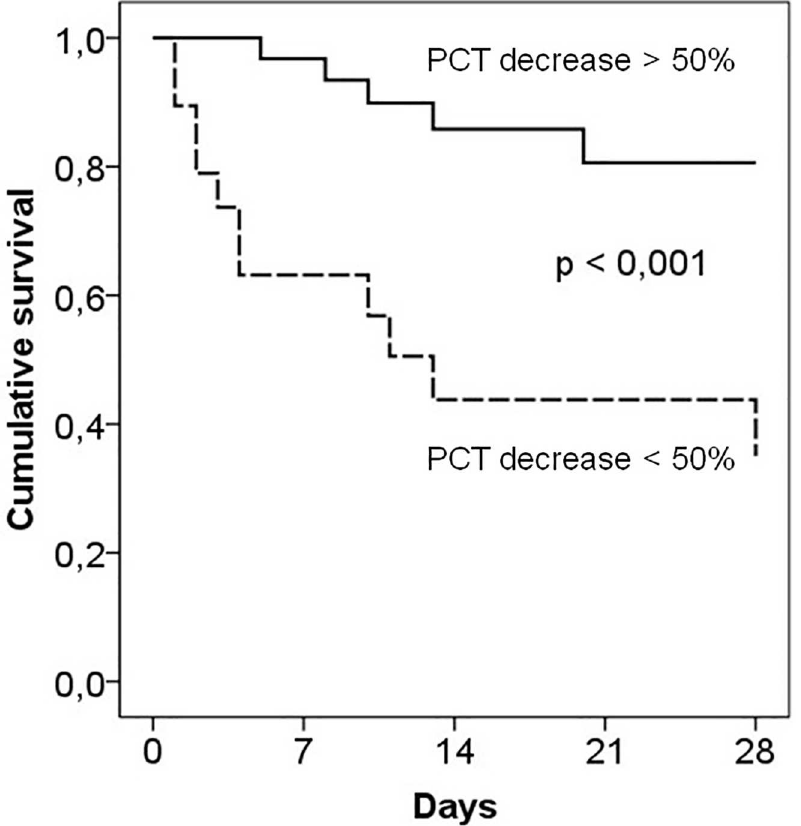
Fig 4. Kaplan Meier curves of survival of patients with severesepsis/septic shock classified in function of a decreaseof procalcitonin levels higher (continuous line) or lower (dashed line) than 50% from day 0 to 5 of ICU stay. A significant difference was detected amongboth groups of